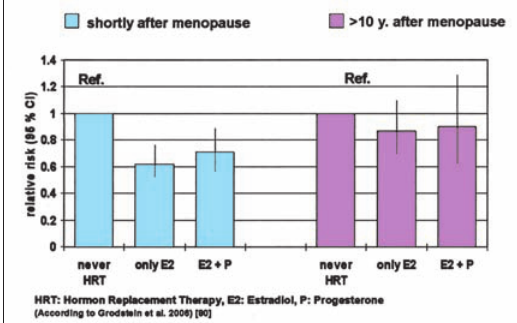
Nurses’ Health Study: Risk of developing coronary heart dis- ease according to menopausal